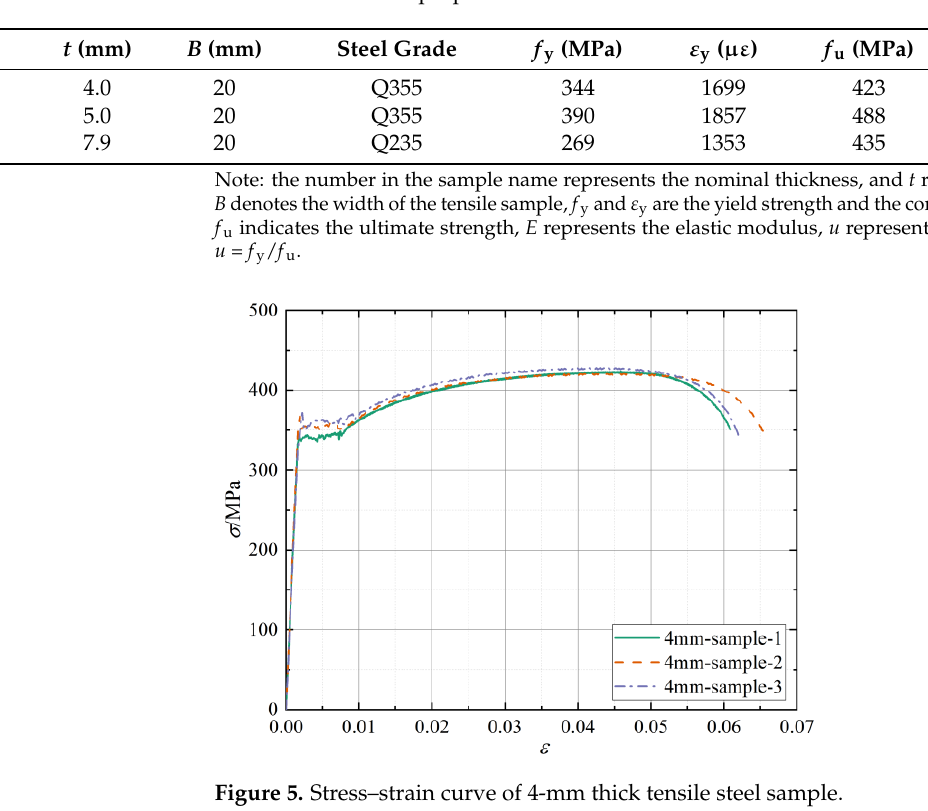
Table 2. Mechanical properties of steel.